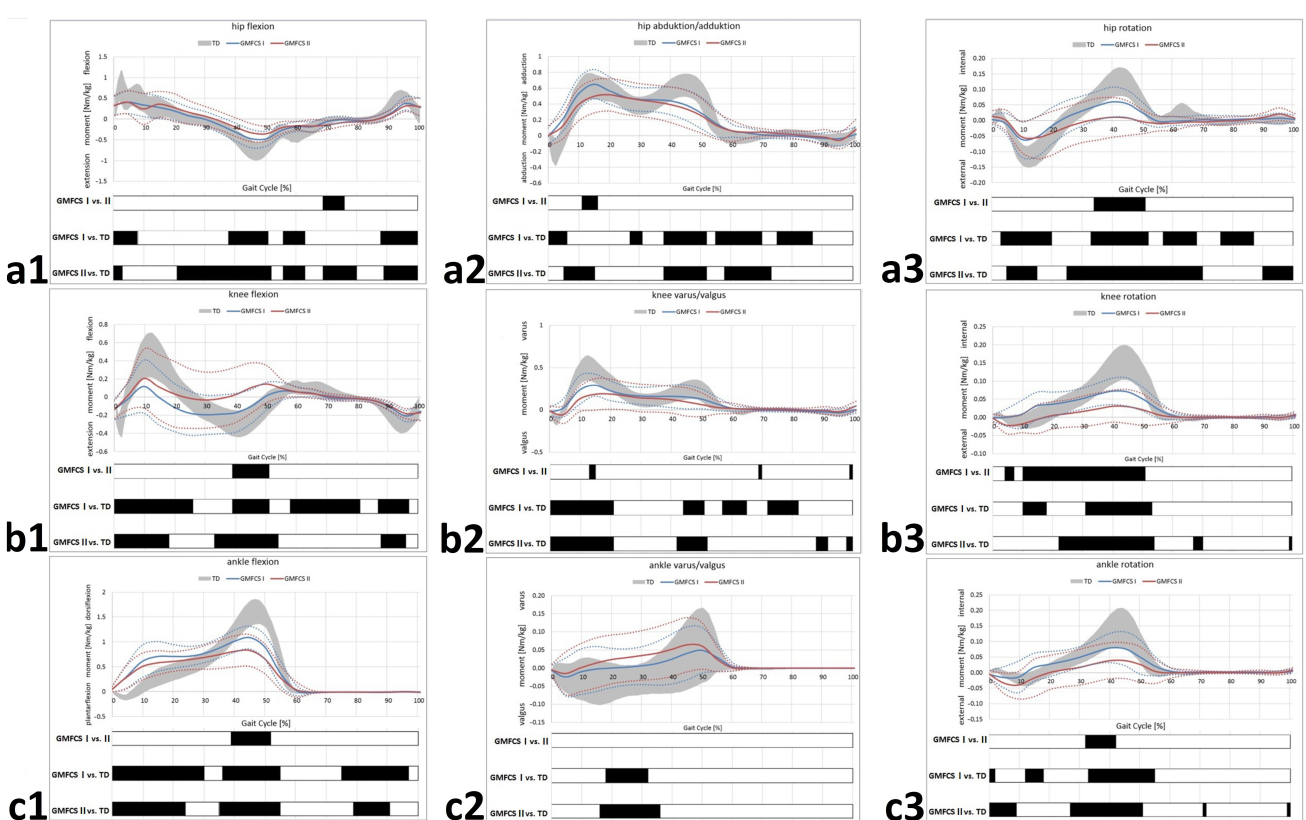
Figure 2. GMFCS level-specific joint moments. Hip moments ( a1 – a3 ); knee moments ( b1 – b3 ); ankle moments ( c1 – c3 ). TD group (age-matched typically developing individuals) of the gait laboratory data base. Black bars represent the results for SPM and indicate periods of significant differences throughout the gait cycle. Straight lines represent the mean of the involved limb of the participants with CP. Dotted lines indicate a range of ± 1